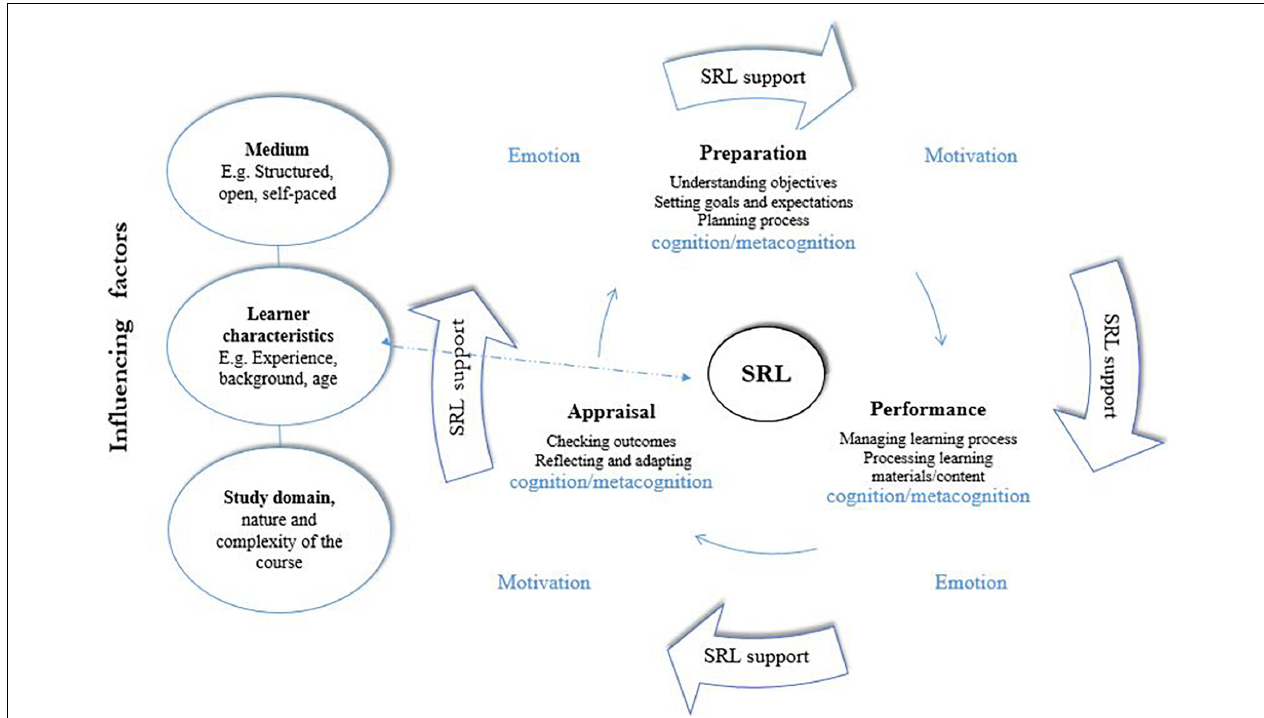
FIGURE 3 | Self-regulated learning process: SRL stages and areas, strategies used, the dynamics of support provision and external factors